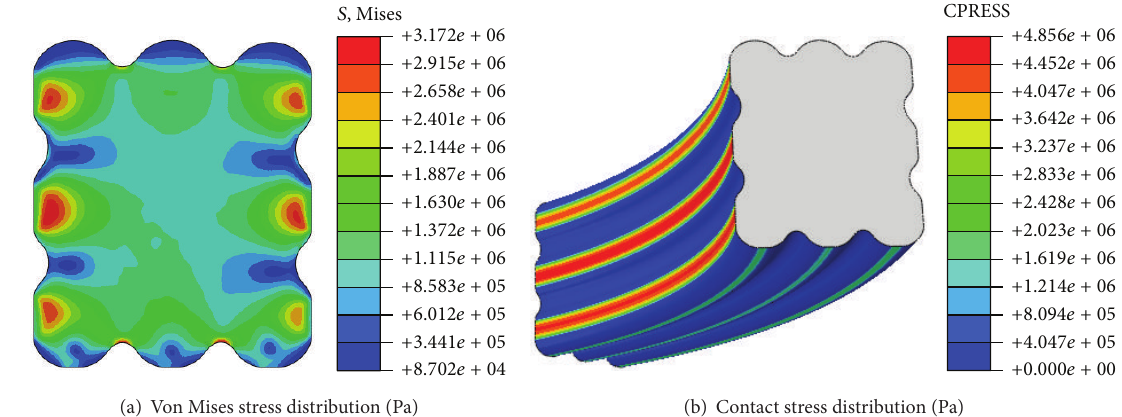
Figure 6: Stress distribution of sealing ring under no-pressure condition.